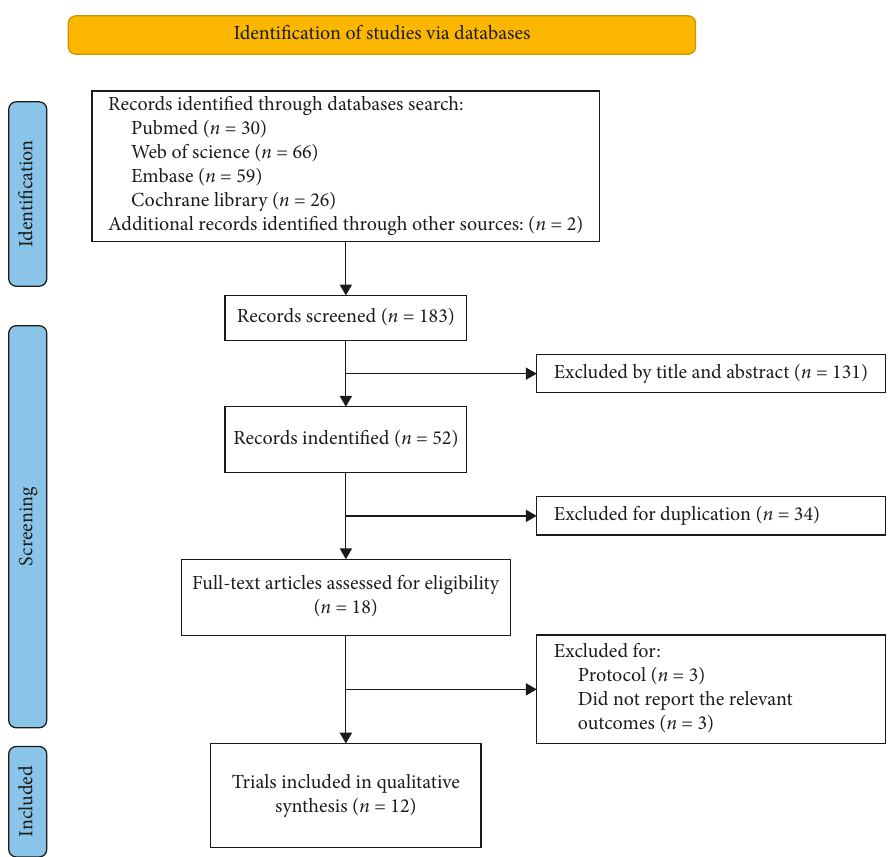
Figure 1: PRISMA flow